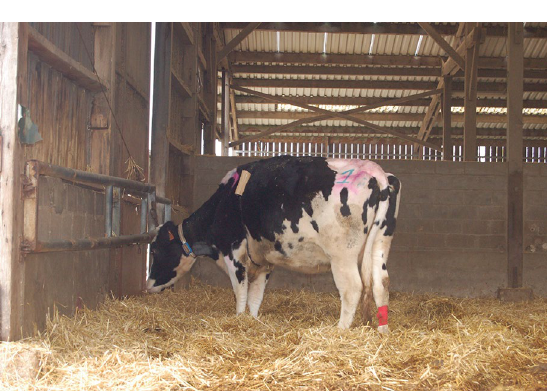
Figure 2. Cow displayed apathy, with head in down position and tail pressed her tail against vulva and